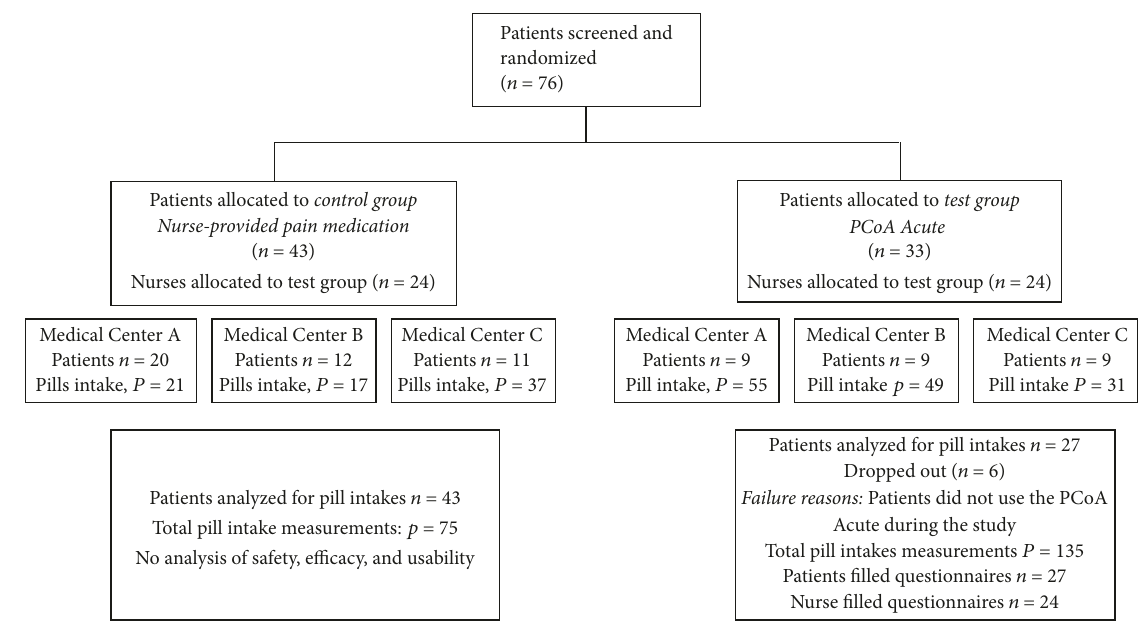
Figure 3: Patients disposition flow